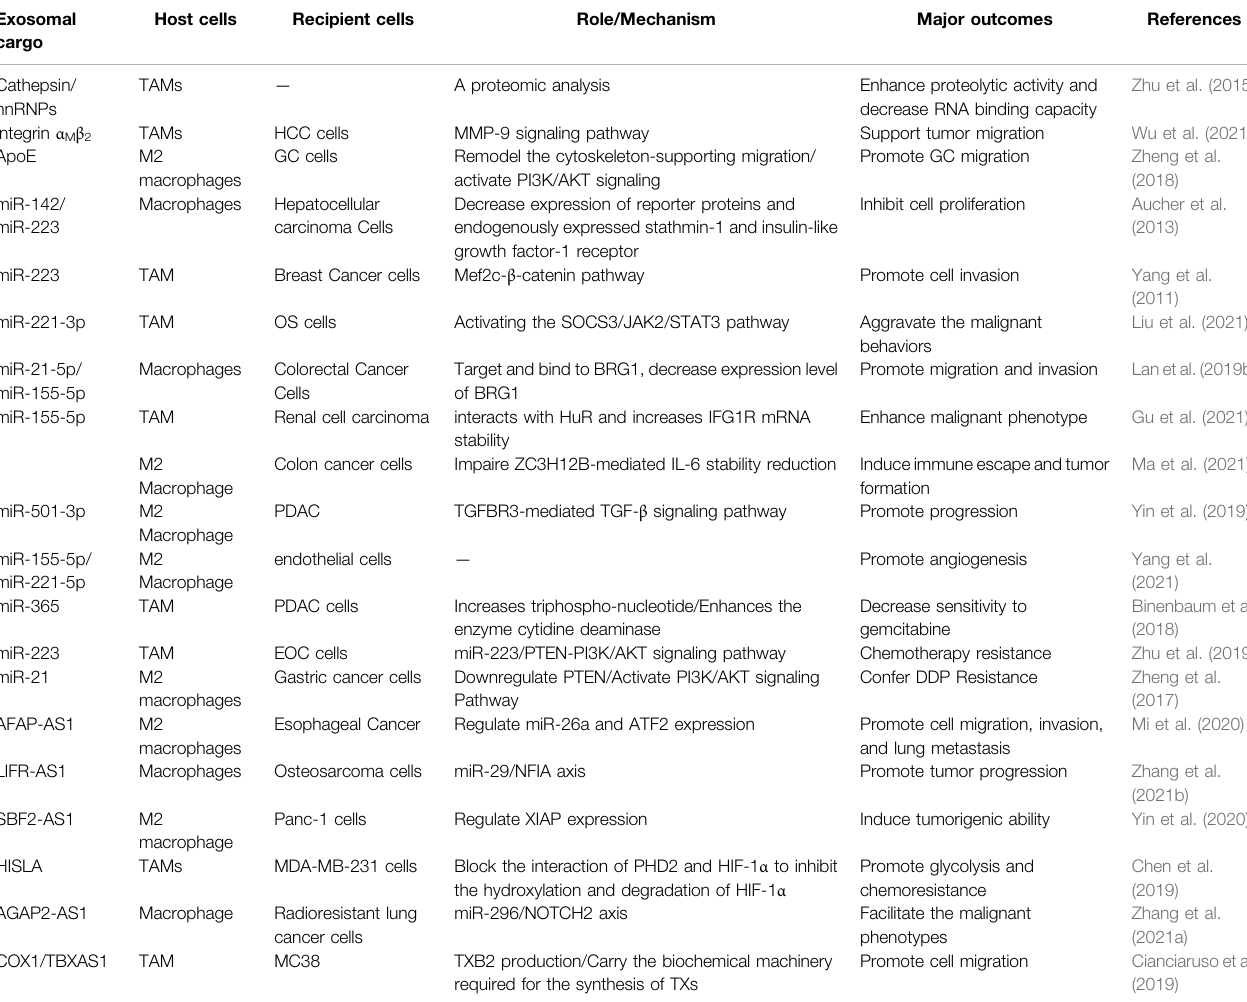
TABLE 2 | Roles of macrophages-derived exosomal cargoes regulate tumor